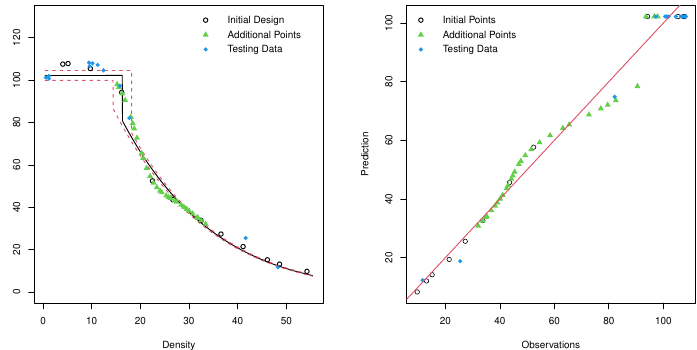
Figure 5. ( Left ): Computer model after calibration and the 95% prediction confidence interval, using the proposed method. ( Right ): Observations vs. predictions of the calibrated computer